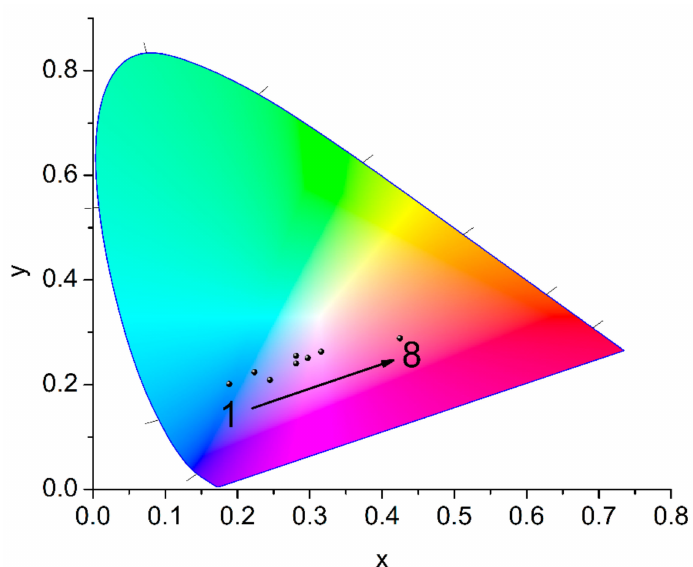
Figure 7. Chromaticity coordinates (CIE 1931) calculated from the corrected emission profiles of materials 1 – 8 showing the gradual shift from blue to red upon increasing the Eu 3 +